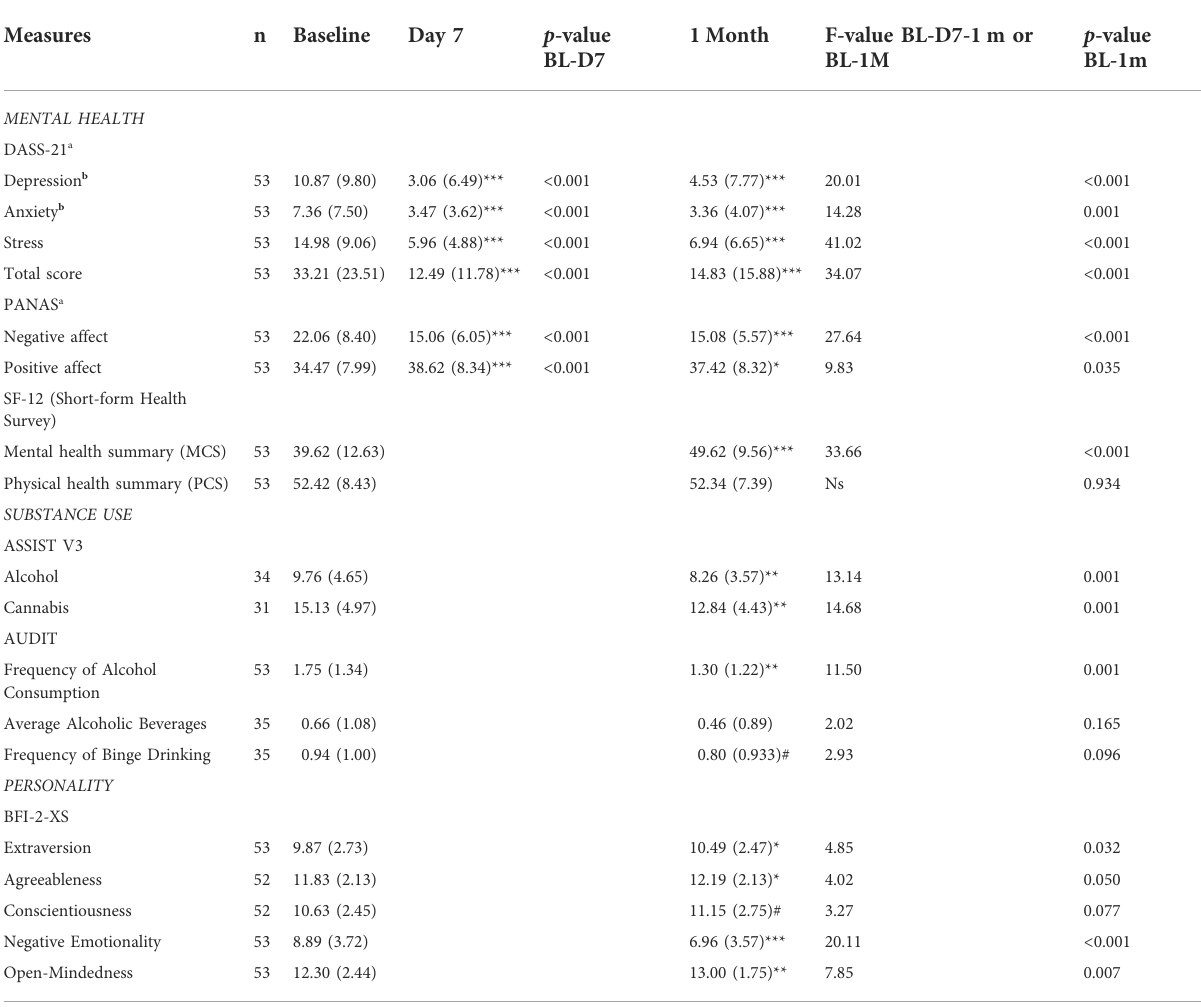
TABLE 1 Primary outcomes repeated measures at baseline, day seven (where available), and 1 month. Values are given as means (standard deviations in brackets).